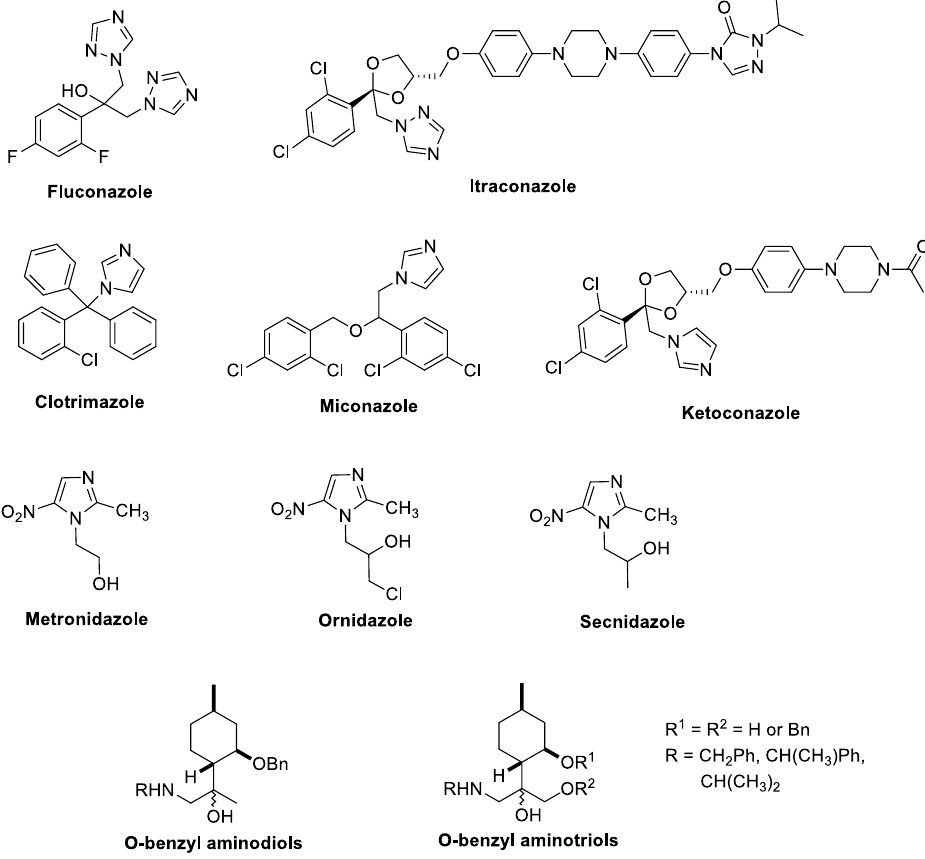
Figure 1. Azoles as potent antimicrobial agents